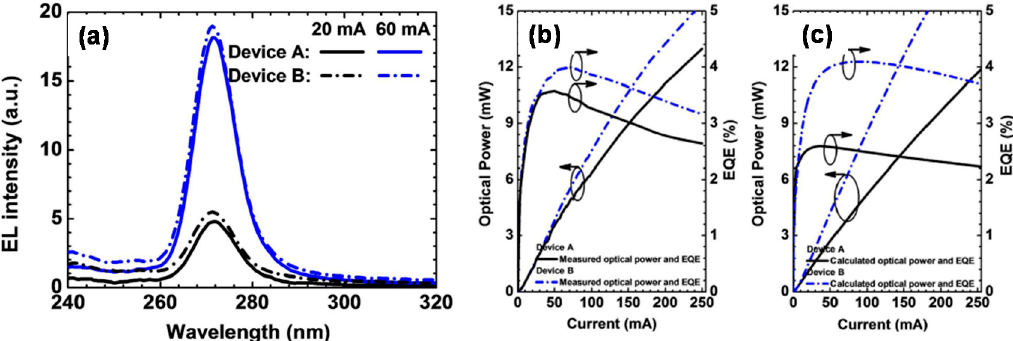
Figure 8. ( a ) Experimentally measured EL spectra; ( b ) experimentally measured EQE and optical power, and ( c ) numerically calculated EQE and optical power for Devices A and B, respectively. Reproduced from Ref. [24], with the permission of American Chemical Society.